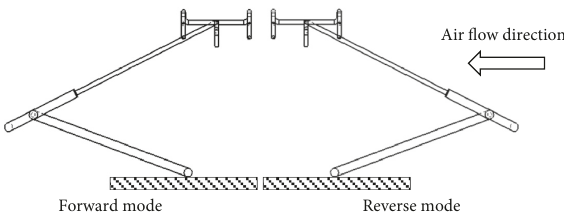
Figure 17: Pantograph position in forward- and reverse-motion modes as proposed in the present